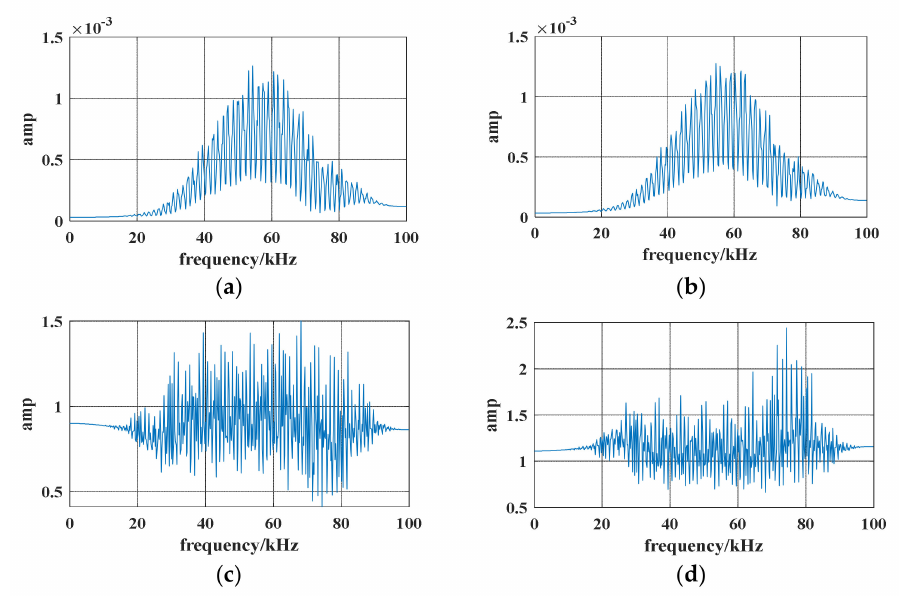
Figure 2. Simulation results of the line-mode current spectrum and frequency-domain current ratio under an internal fault: ( a ) current spectrum on the M side; ( b ) current spectrum on the N side; ( c ) frequency-domain current ratio I M / I N ; ( d ) frequency-domain current ratio I N / I M